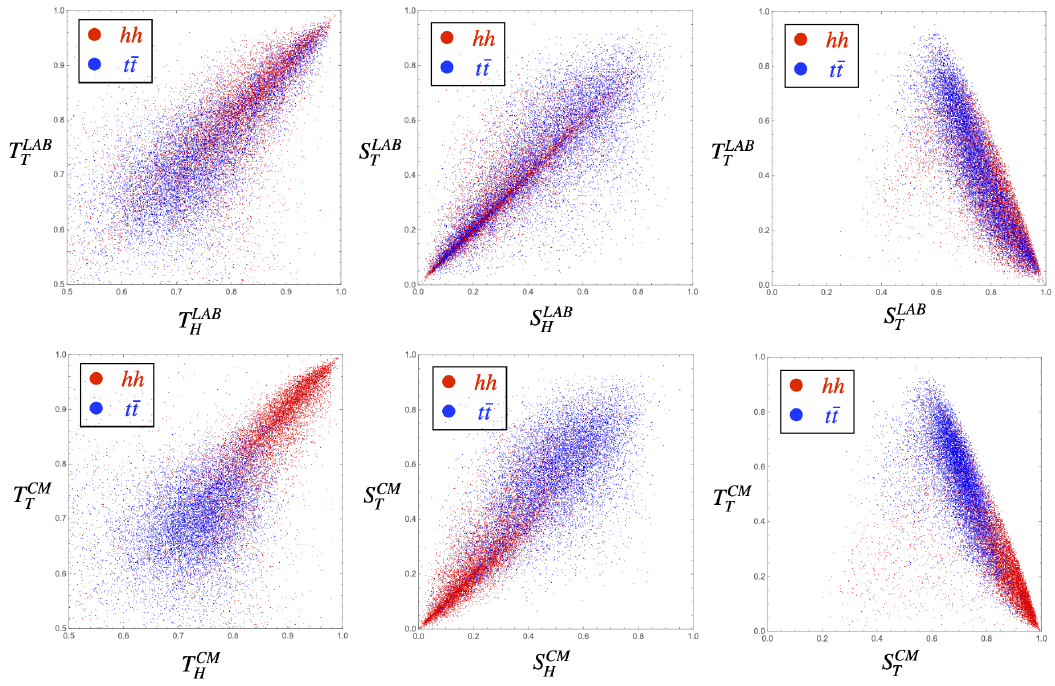
Figure 18 . Thrust (left), sphericity (middle) and thrust vs. sphericity (right) in the lab frame (top) and CM frame (bottom) for the hh (red) and t ¯ t (blue) productions. The quantities with subscript ‘H’ (‘T’) are obtained using Higgsness